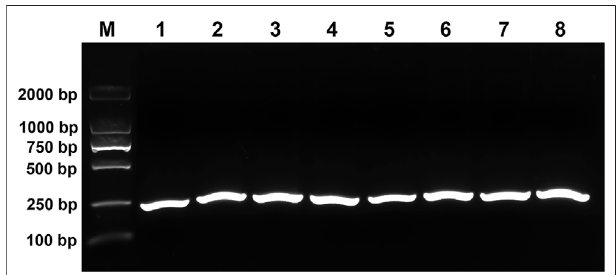
FIGURE 2 | Evaluation of the performance of RPA primers. M, DL2000 DNA marker; 1 – 8, RPA products ampli fi ed at 25 ° C, 28 ° C, 32 ° C, 35 ° C, 37 ° C, 39 ° C, 42 ° C, and 45 ° C,